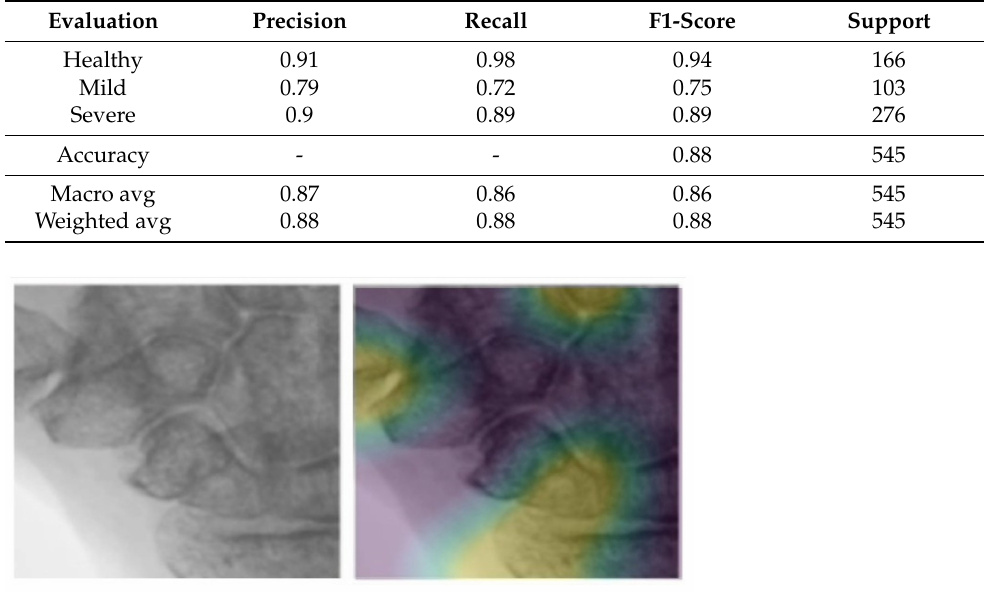
Figure 7. Explanation of the model compared with the heatmap for the classification results in a wrist joint